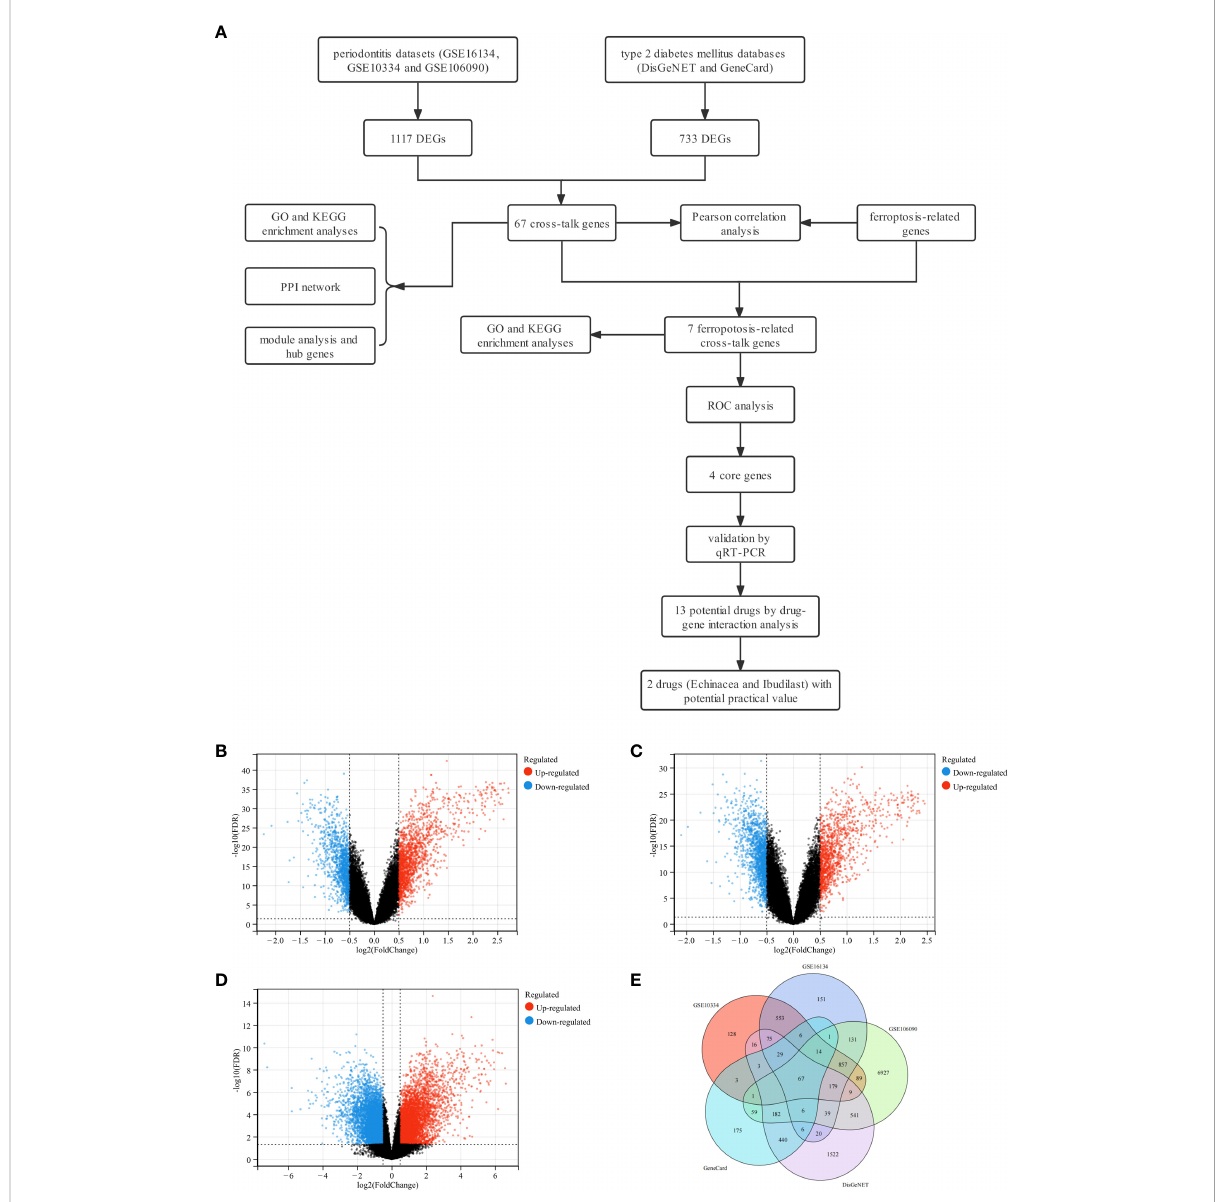
FIGURE 1 Study design fl owchart, volcano diagram and venn diagram. (A) The detailed fl owchart of the study. (B) The volcano map of GSE16134. (C) The volcano map of GSE10334. (D) The volcano map of GSE106090. Upregulated genes are marked in red; downregulated genes are marked in blue. (E) Venn diagram of cross-talk genes from three datasets and two